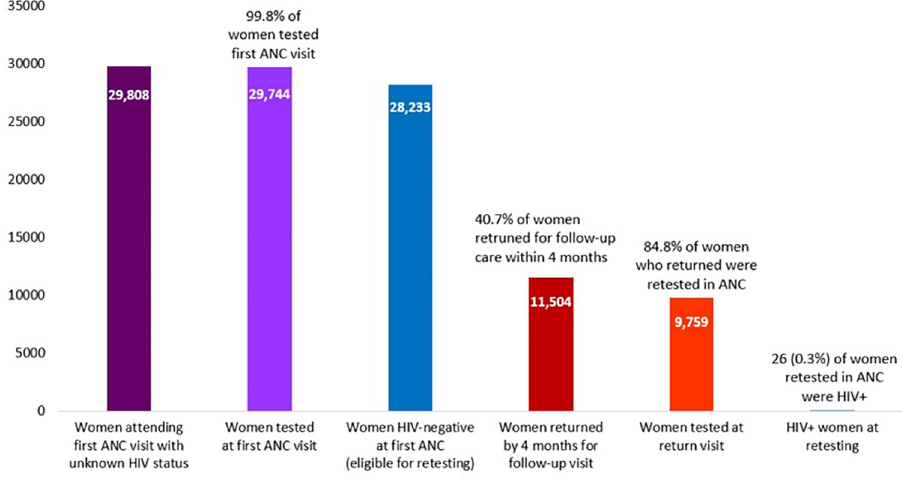
Fig 2. Antenatal clinic HIV retesting cascade, 10 health facilities in Nampula, Mozambique, April-November 2019.